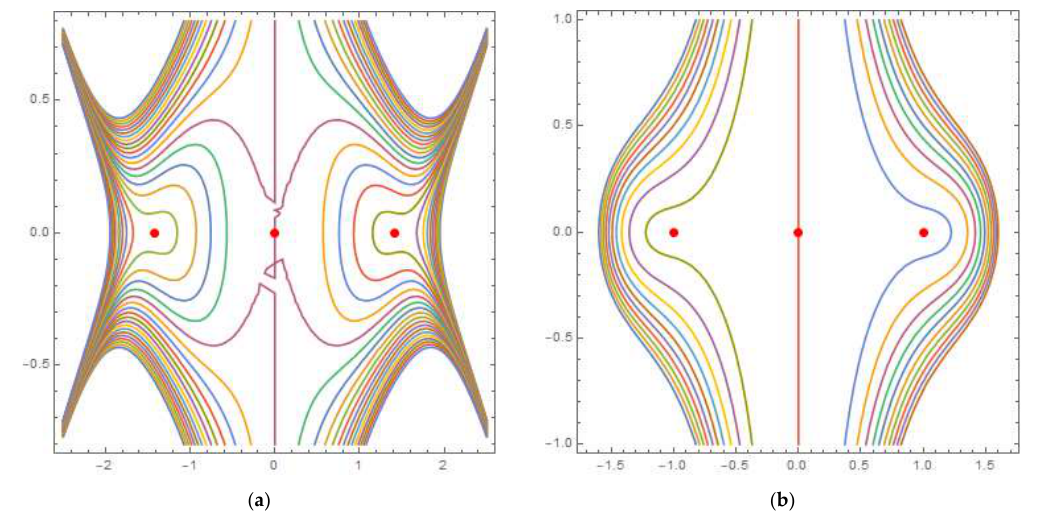
Figure 1. Trajectories of the dynamical system (17), where ( a ) a 1 = 1, a 2 = 0, a 4 = 0, q 1 = 2, q 3 = 1, γ = 1, δ = 1, β = 1, q 2 = − ( q 1 ) ; ( b ) a 1 = 0, a 2 = 0, a 4 = 0, q 1 = − 2, q 3 = 1, γ = − 1, δ = 1,𝛽 = 1,𝑞 = − (𝑞 1 ) .